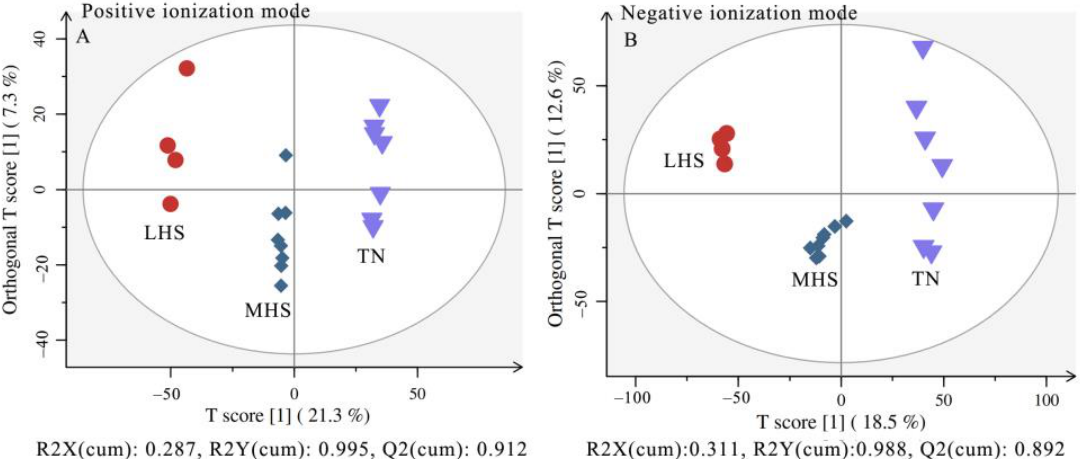
Figure 3. Differentiation of metabolic profiles of yaks under TN, LHS, and MHS conditions using multivariate analysis. ( A , B ) OPLS-DA plots of the LC − MS data for the plasma metabolome in positive and negative ionization modes. TN = Thermal-neutral, LHS = Light heat stress, and MHS = Medium heat stress. Table 3. Distinct plasma metabolites from three carbohydrate metabolism pathways.